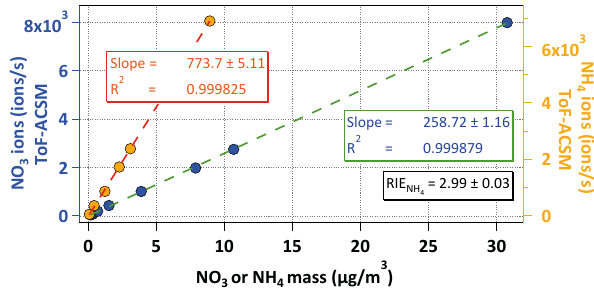
Fig. 3. NO 3 (blue) and NH 4 (orange) ionic signals from the mIE calibration plotted against the mass of the respective species, calcu- lated from the output of the CPC. The dashed lines represent linear fits to the NH4 (red) and NO3 signals (green). The corresponding slopes and coefficients of determination are given in the boxes (red: NH 4 ; green: NO 3 ). The RIE NH was calculated from the ratio of 4 the determined